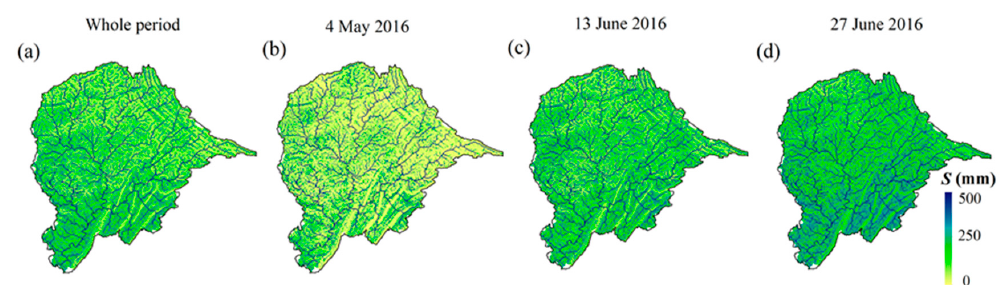
Figure 9. Overall averages of DDRM model-simulated soil moisture storage depth over the whole period ( a ), and DDRM model-simulated soil moisture storage depth on the fourth of May ( b ), the thirteenth of June ( c ) and the twenty-seventh of June ( d ) during a water-rising stage of 2016. The resolution is 1 km.